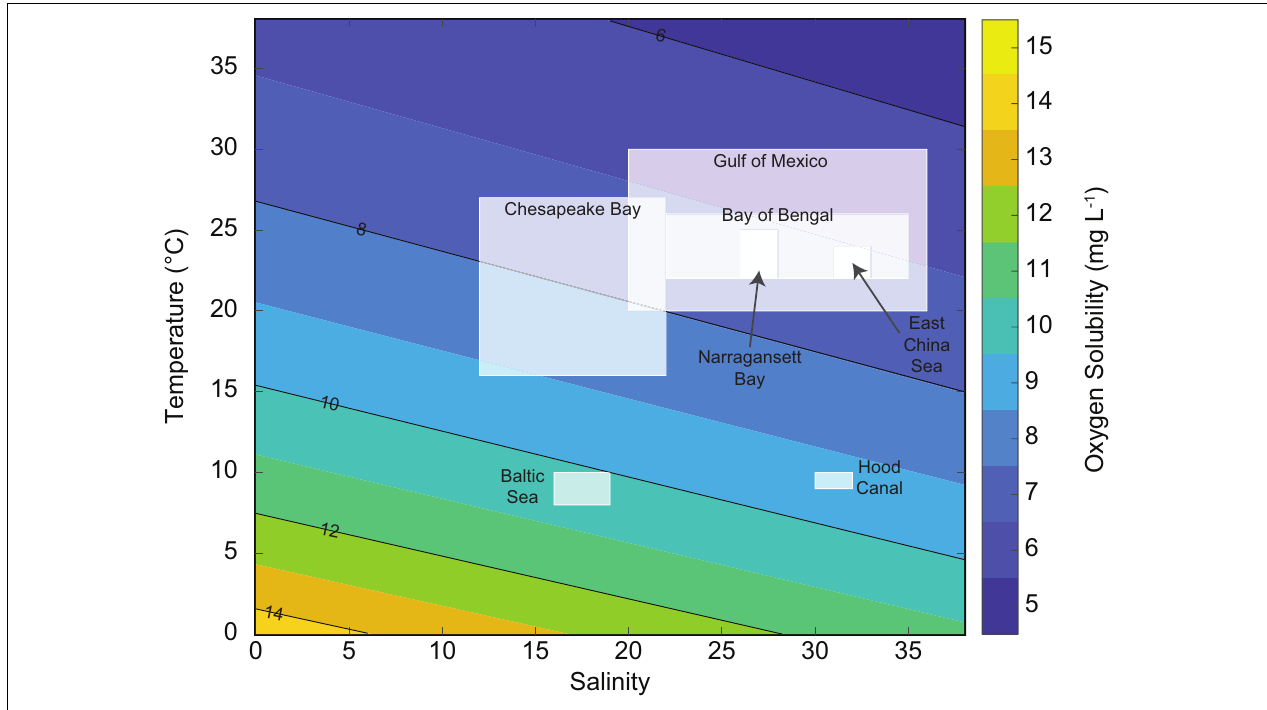
FIGURE 2 | Oxygen solubility (mg L − 1 ) is shown by the color scale at different salinity and temperature ( ◦ C) conditions, with boxes indicating the range of salinity and temperature during periods of seasonal deoxygenation for seven coastal and estuarine bodies of water around the world. Oxygen solubility calculated using the equations of Benson and Krause (1980, 1984), assuming surface water pressure.